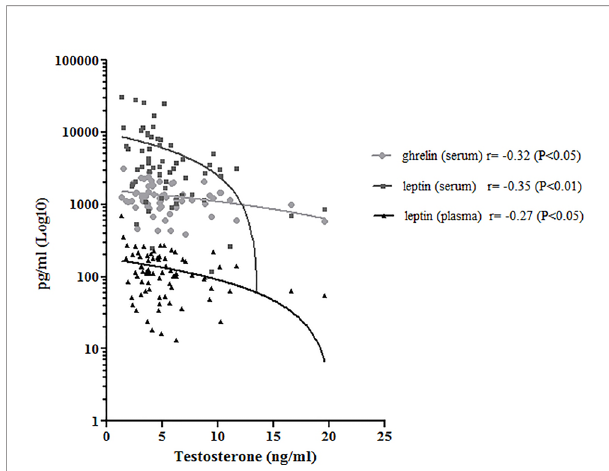
FIGURE 4 | Correlation analysis between serum ghrelin (light gray) and leptin (dark gray), plasma leptin (black) and testosterone. Pearson ’ s Rho correlation and signi fi cance was